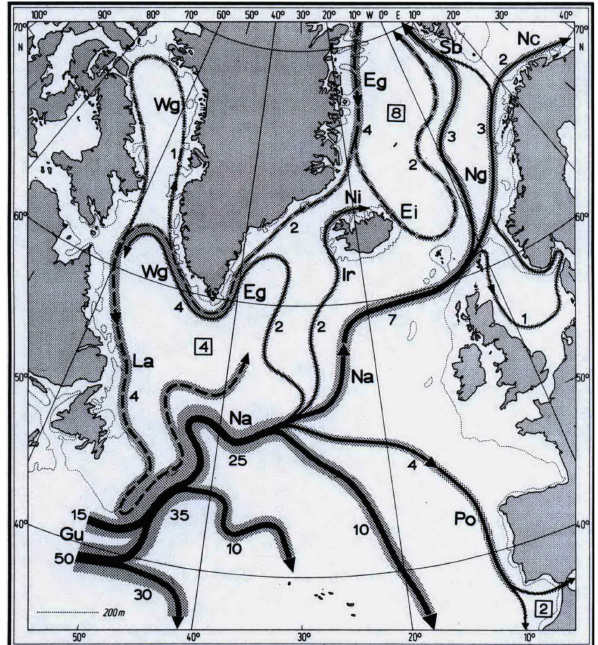
Fig. 2. Scheme of water transport (in 10 6 m 3 s − 1 ) in the layer 0– 1000m in the northern North Atlantic Ocean. (Derived from Weg- ner, 1973). After Dietrich et al.